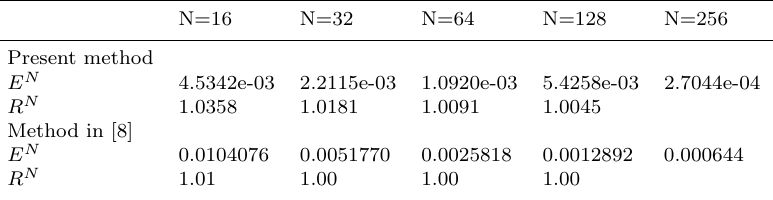
Table 3. Comparison of ε -uniform maximum absolute errors and rate of convergence for Example 1. N=16 N=32 N=64 N=128 N=256